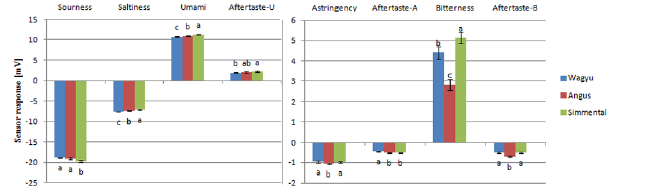
Fig 2. Flavor assessment of different breed beef.